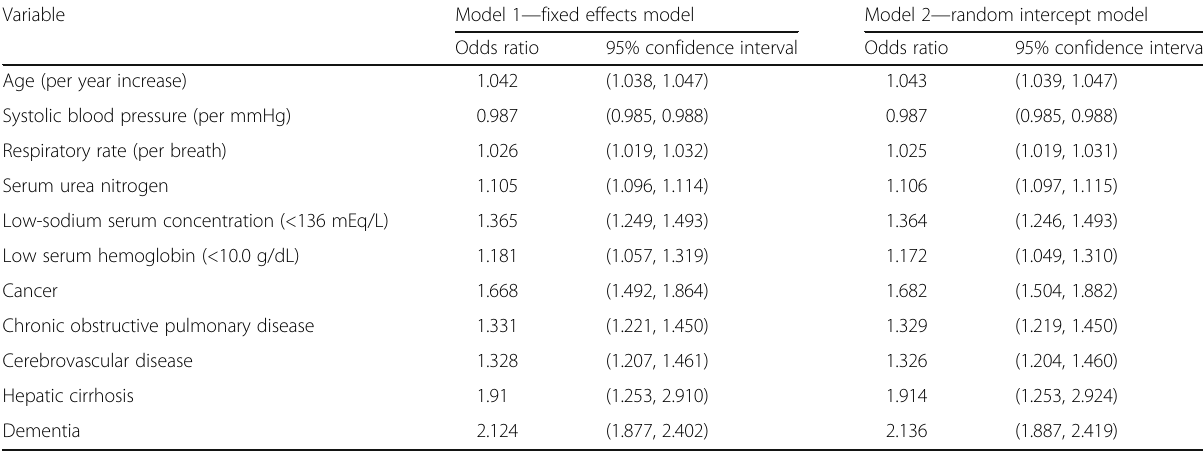
Table 1 Estimated odds ratios from fixed effects and random intercept model